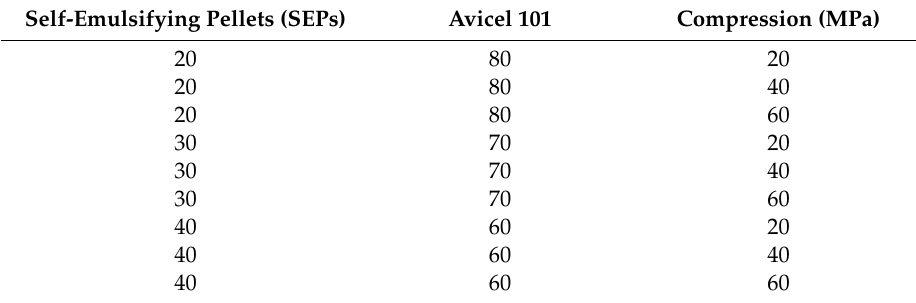
Table 3. Composition (%) of self-emulsifying tablets and compression pressures applied for their preparation. Self-Emulsifying Pellets